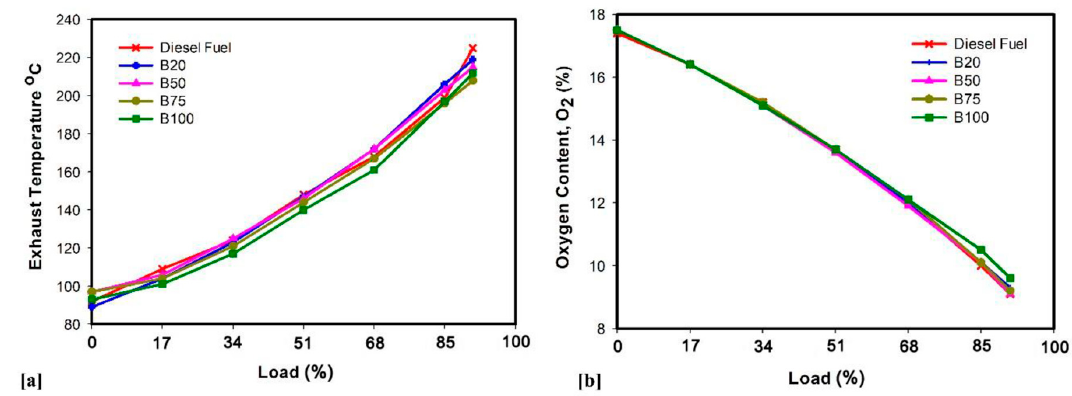
Figure 9. ( a ) Exhaust gas temperature and ( b ) oxygen content (O 2 ) as a function of load for diesel, sheep fat biodiesel (B100) and biodiesel blends (B25, B50 and B75) fuels.